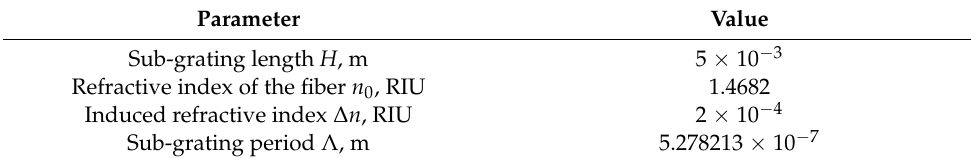
Table 2. Modeling parameters of the π -phase-shifted FBG.